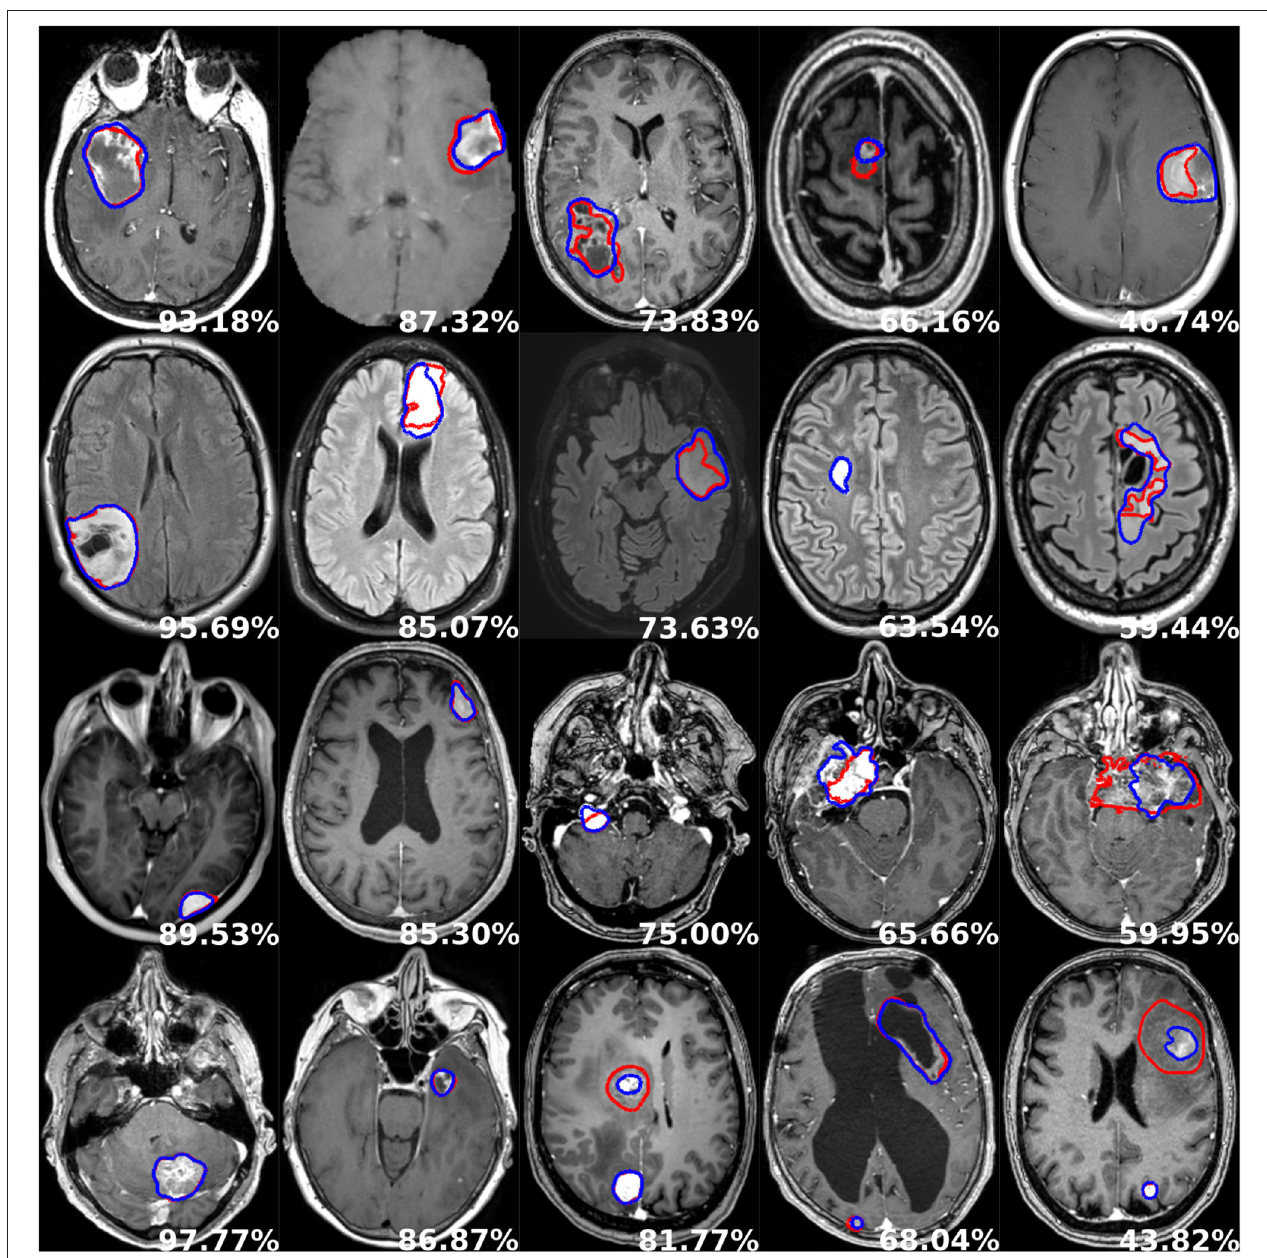
FIGURE 5 | Examples of segmentation performances. One row illustrates one tumor type: glioblastoma, lower grade glioma, meningioma, metastasis (from top to bottom), and each column depicts a different patient. The manual delineation is shown in red, the automatic segmentation in blue, and the patient-wise Dice score in